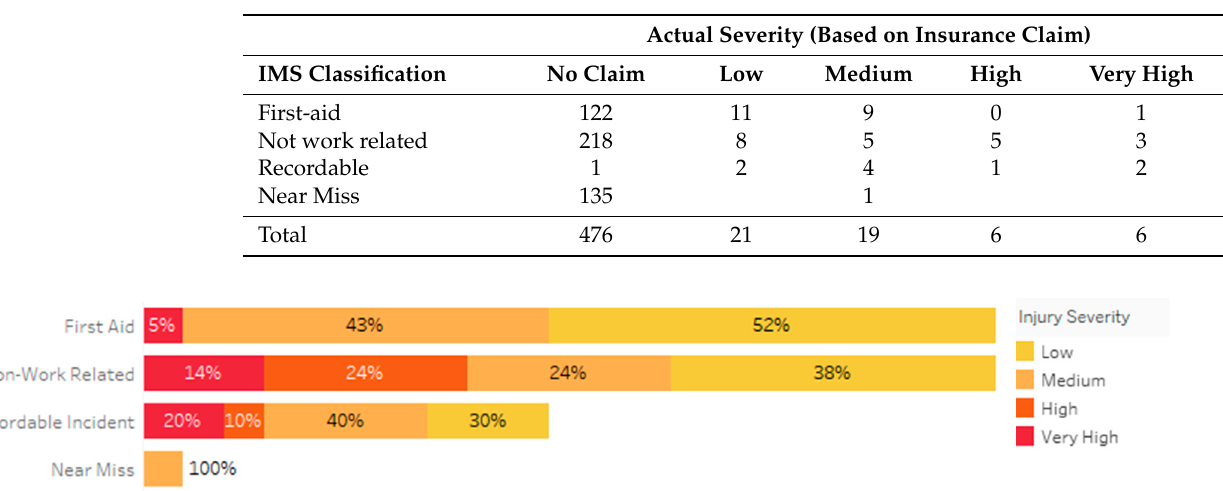
Table 2. Contingency table of injury severities and IMS classifications.